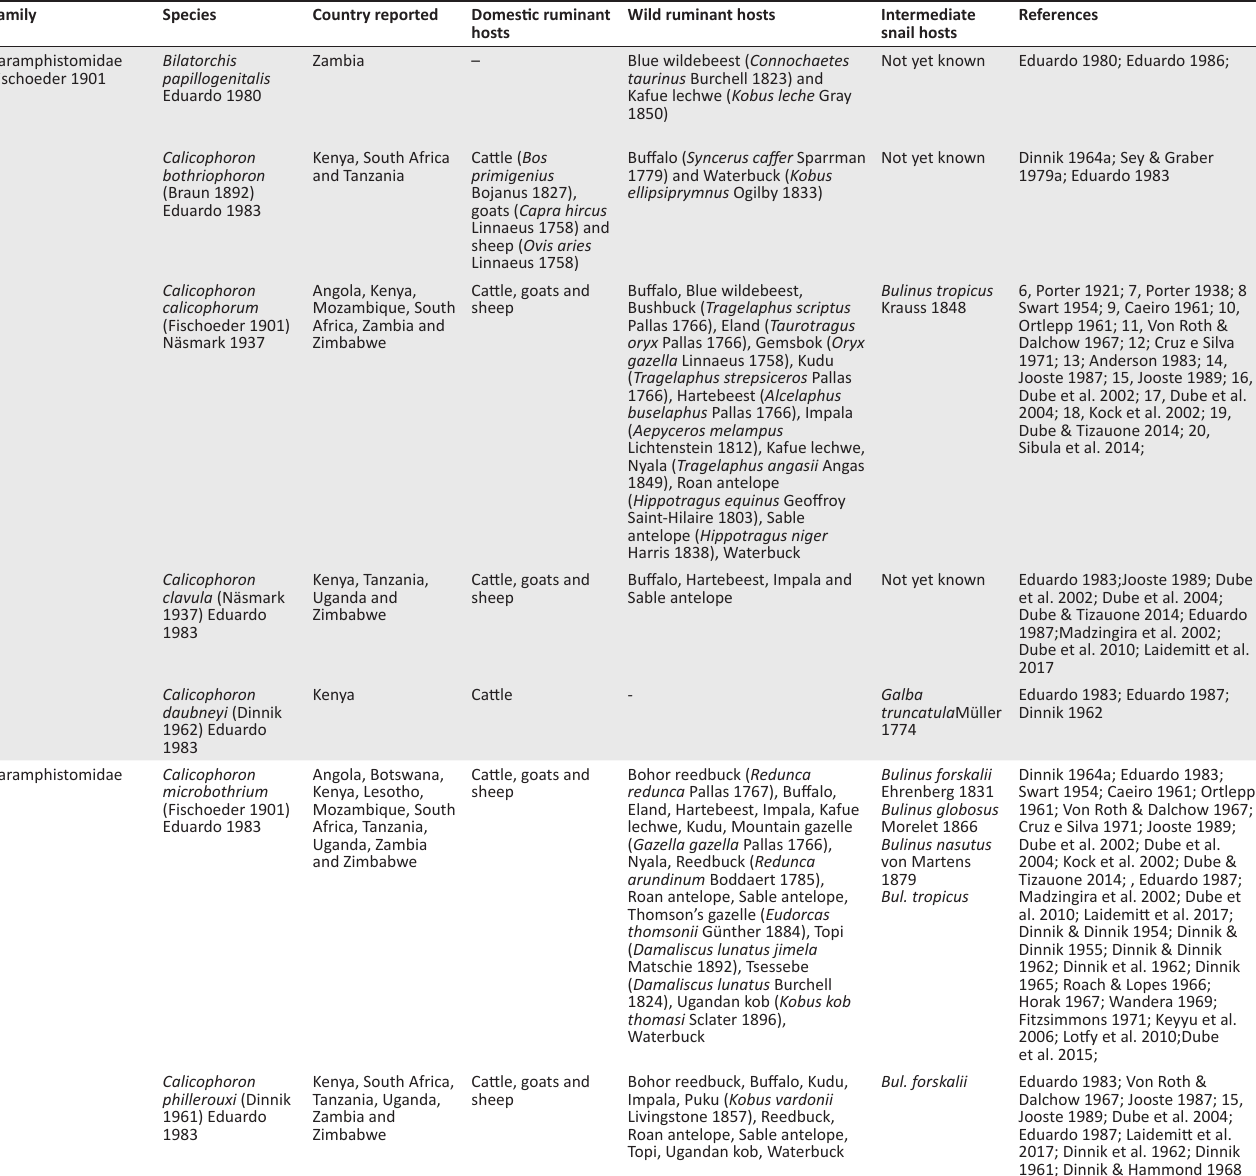
TABLE 1: Checklist of amphistome species and their ruminant and snail intermediate hosts reported in east and southern African countries.